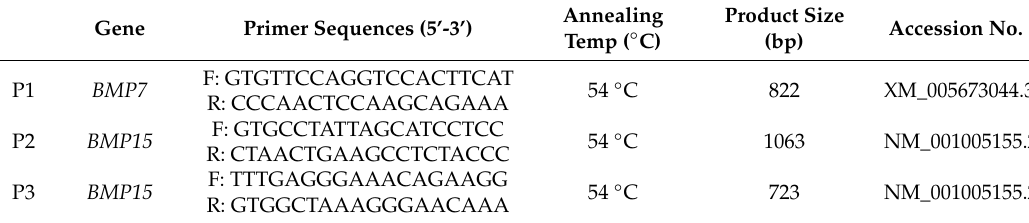
Table 1. Primers used in this